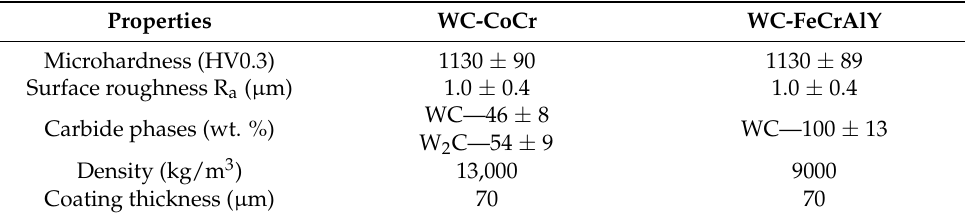
Table 1. The properties of the coatings (WC-CoCr and